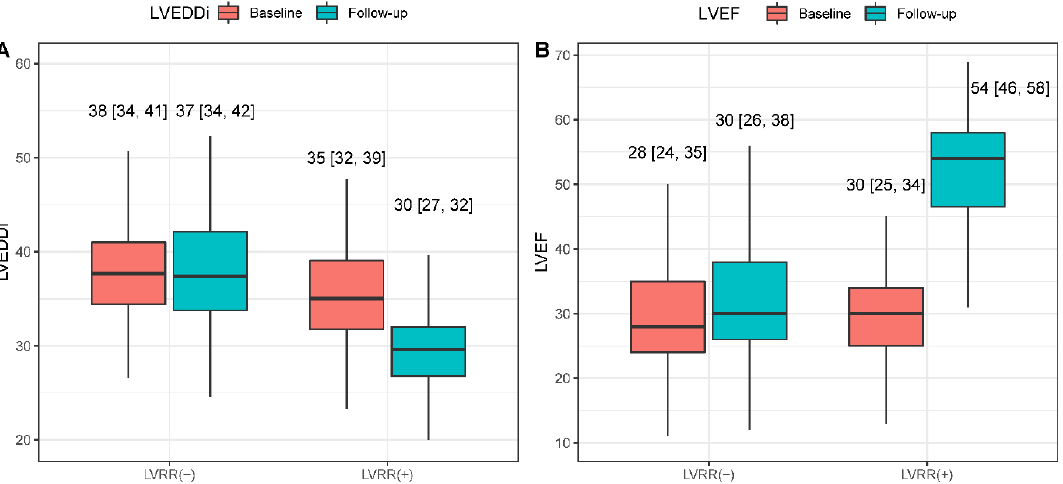
Figure 1. Changes of LVEDDi and LVEF in DCM patients with LVRR and without ( A , B ). LVEDDi: left ventricular end-diastolic diameter index; LVEF: left ventricular ejection fraction; LVRR: left ventricular remodeling. Table 1. Baseline characteristics for DCM patients with LVRR absent and LVRR present.